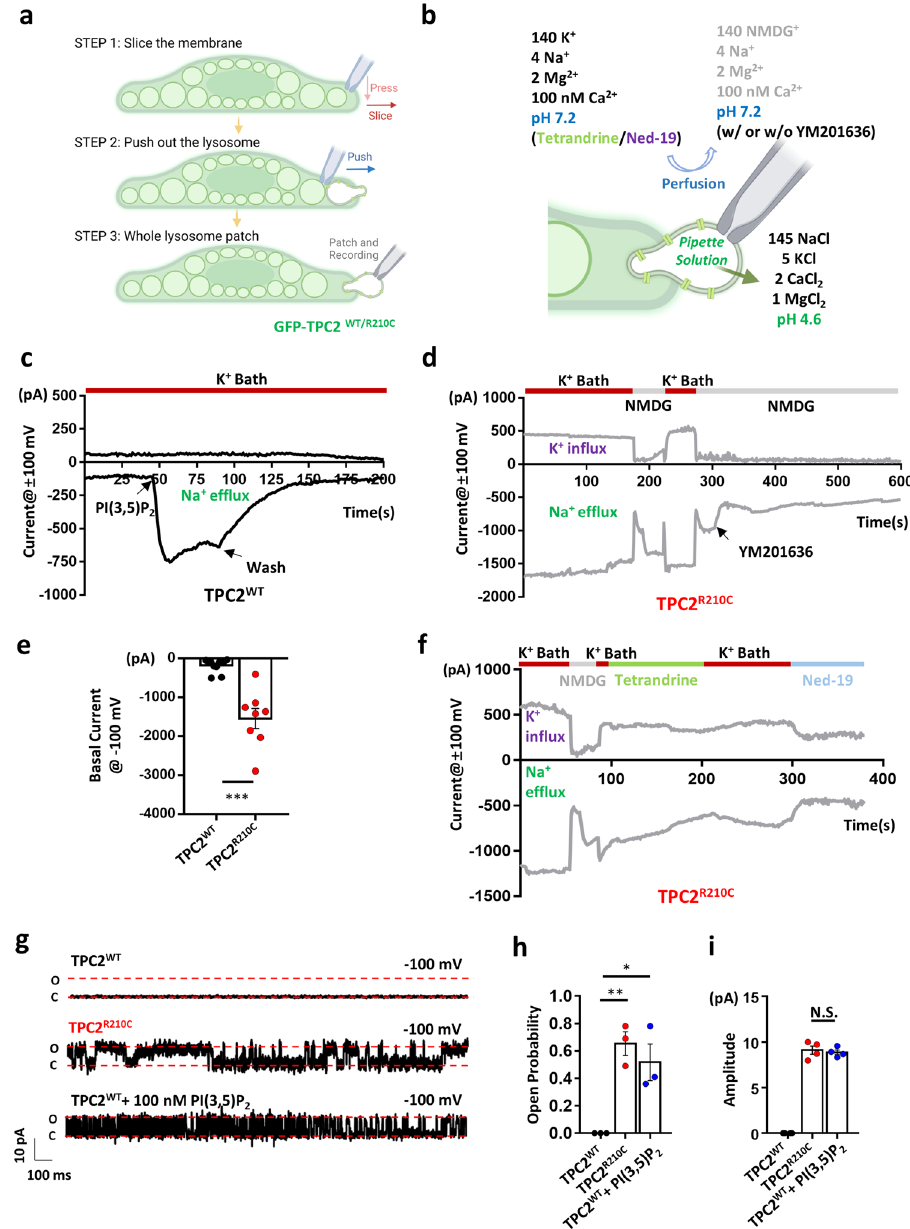
Fig. 5 | Lysosome-localized TPC2 R210C is constitutively active and displays altered ion permeation. a A cartoon (drawn using BioRender with permission) depictingthethree-stepprotocolusedforwhole-endolysosomerecordingfroman enlarged endolysosome. b A cartoon (drawn using BioRender with permission) depicting the whole-endolysosome con fi gurationand solutions used for inhibiting constitutive currents of R210C in endolysosome patches. c A typical TPC2 WT response to 1 µ M PI(3,5)P 2 -diC8. d Representative traces of lysosomal TPC2 R210C currentsinresponsetoNMDG + andYM201636(800nM)asindicated.Theoutward current at +100mV carried by K + was eliminated by substituting all cations in the bath solution with NMDG + . The inward current at − 100mV was sensitive to YM201636, a potent PIKfyve inhibitor that blocks PI(3,5)P 2 synthesis. e Analysis of the basal current of TPC2 WT and TPC2 R210C at − 100mV under the resting condition. WT: − 49.5±8.7 pA ( n =11), R210C: − 898.1±346.2 pA ( n =8). Data are presented in mean±SEM, *** p <0.001 by Student ’ s unpaired t -test, two-tailed. Source data are provided as a Source Data fi le. f Example traces of R210C currents recorded in whole-endolysosome con fi guration. NMDG + , tetrandrine (2 µ M) and Ned-19